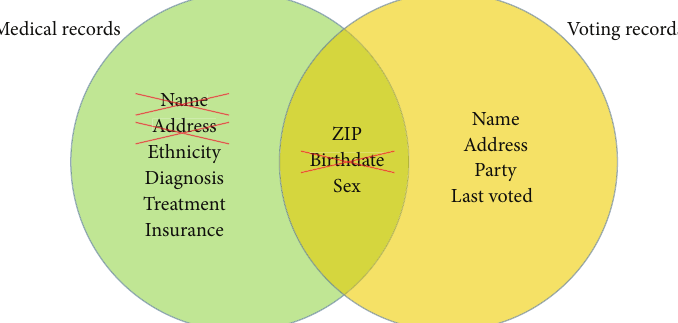
Figure 7: Illustration of the 𝑘 -anonymity concept using record linkage. Medical records contain a number of different fields which are removed to protect confidentiality, including name and address. When combined with voting records, however, it becomes possible to uniquely identify individuals in the medical records by combining fields for ZIP code, birthday, and sex. The 𝑘 -anonymity provided by the released data is unacceptably low. By removing the field for birthdate (or replacing it with birth year), the 𝑘 -anonymity is substantially increased and may reach acceptable levels. The concept of 𝑘 -anonymity provides a quantitative measure of confidentiality protection. More specifically, it is a number that can be calculated for each subset of the data. For the example of medical record and voting records, values for 𝑘 -anonymity can be calculated prior to release for all combination of ZIP code and sex or any other field of interest. Adapted from